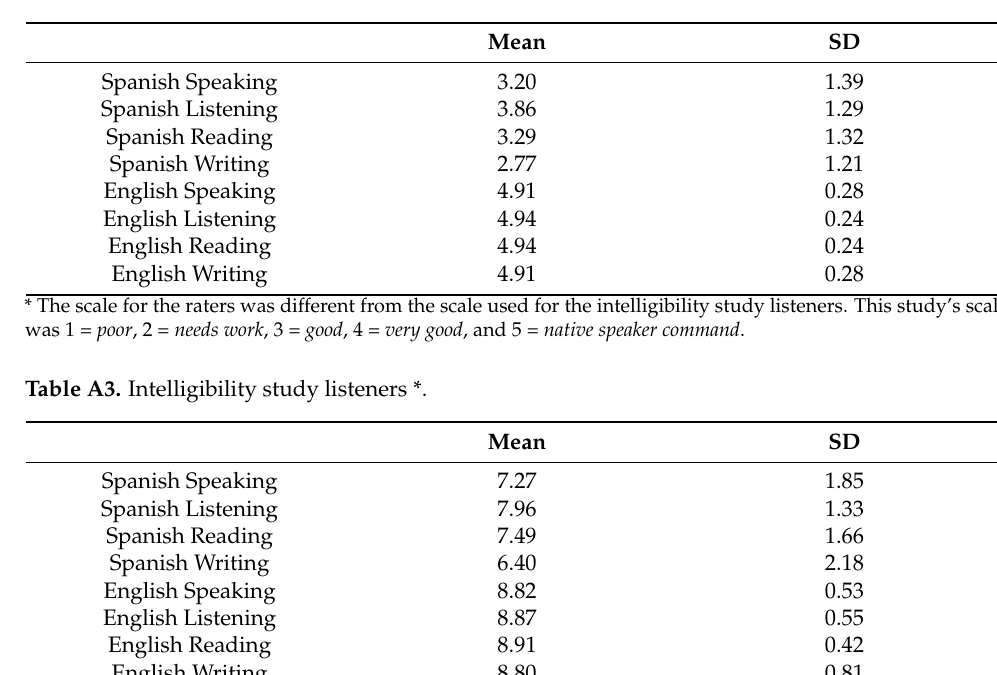
Table A2. Guise validation raters *.